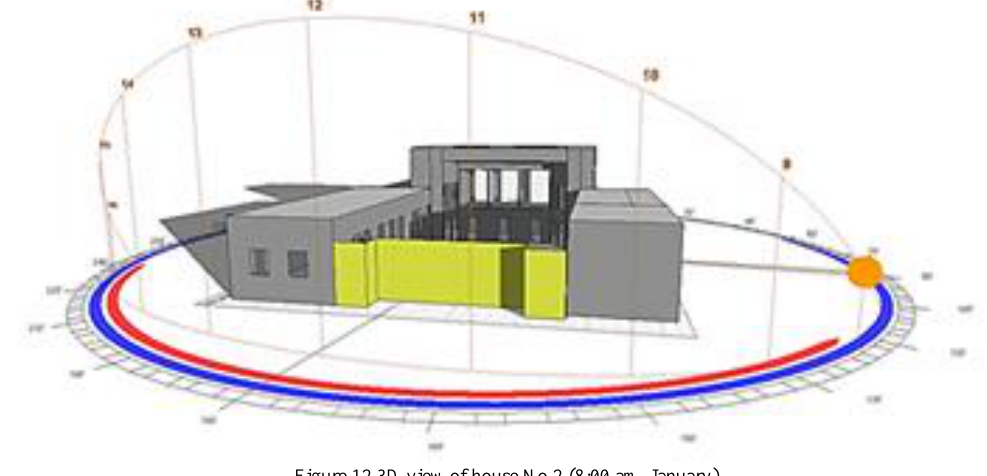
Figure 12 3D view of house No.2 (8:00 am, January)